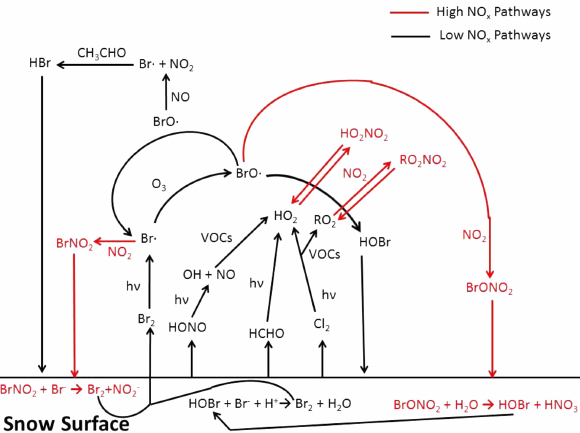
Figure 1. Halogen cycle in the Arctic boundary layer with (red trace) and without (black trace) the influence of anthropogenic NO x (Abbatt et al., 2012; Simpson et al., 2007; Grannas et al.,